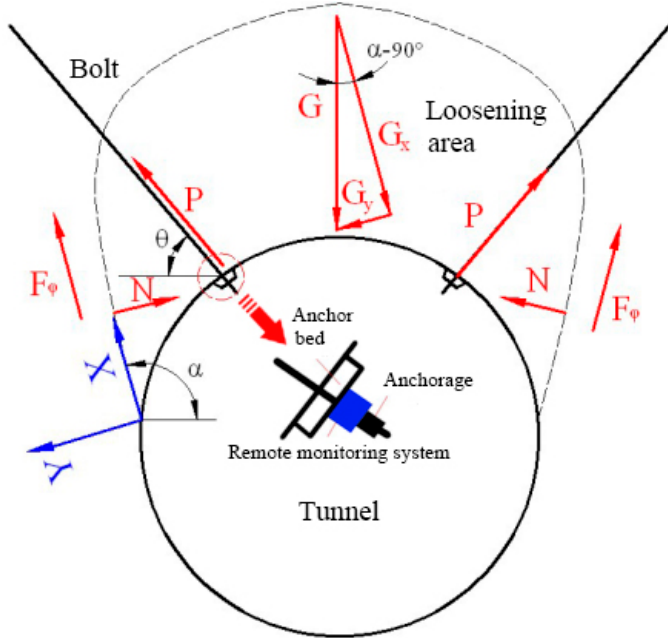
Figure 3. The principle of bolt-based monitoring of the internal force of surrounding rocks for initial support.